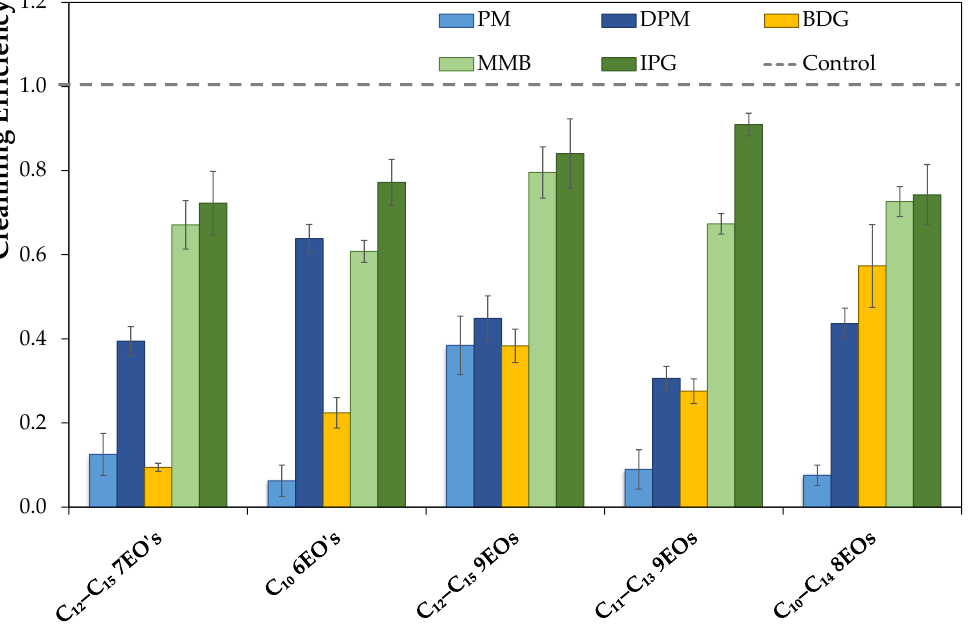
Figure 4. Cleaning efficiency of formulations with nonionic surfactants on stainless steel surface obtained by abrasion scrub test: bars represent the cleaning efficiency of the formulation with different solvents, and error bars are the standard deviation (between 1% and 10%) of at least five independent measurements.